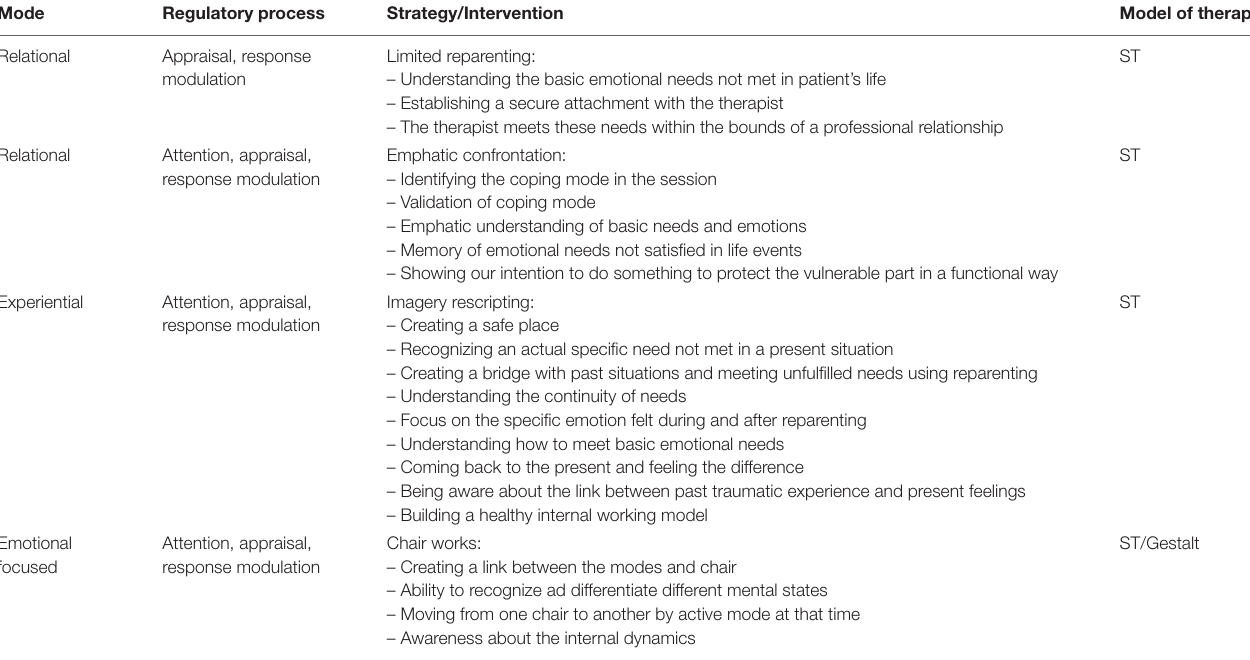
TABLE 4 | Cognitive-experiential techniques for regulating